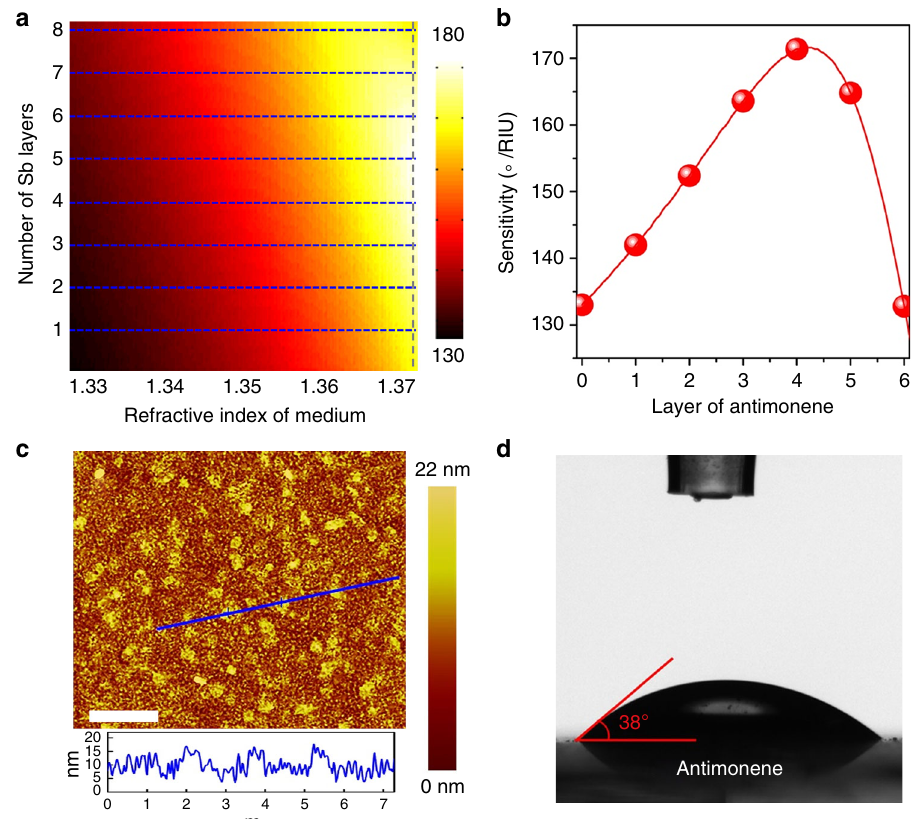
Fig. 4 Simulation of antimonene SPR sensors and the antimonene assembly on the sensor chip. a , b The variation in the sensitivity of the proposed biochemical sensor when the refractive index of the sensing medium is 1.37 + △ n with respect to the different number of antimonene layers. To vividly illustrate the relationship of sensitivity with the number Sb layers, we assume that the number of Sb layers ( n = 2.1 + 0.45 i ) can be continuously changed. c AFM images of antimonene on Au fi lm (scale bar = 2 µ m). d Images of distilled water droplets on antimonene assembled on Au fi